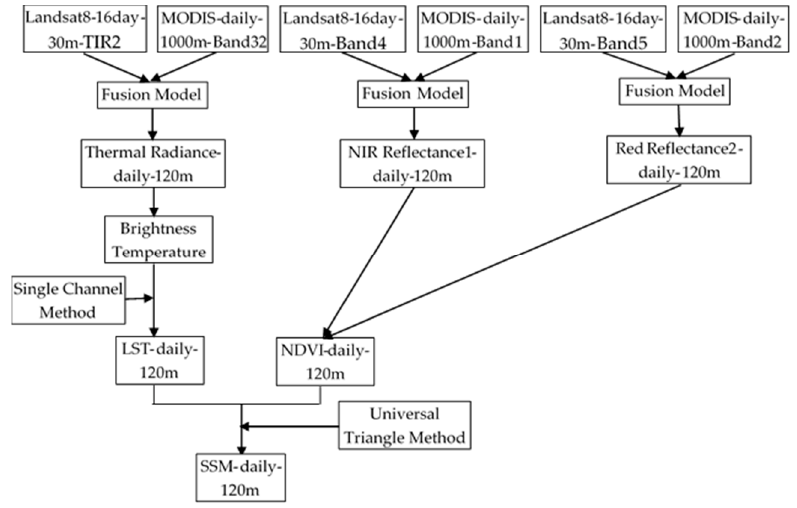
Figure 2. The flow chart for fusing MODIS and Landsat 8 measurements for surface soil moisture (SSM) retrieval.